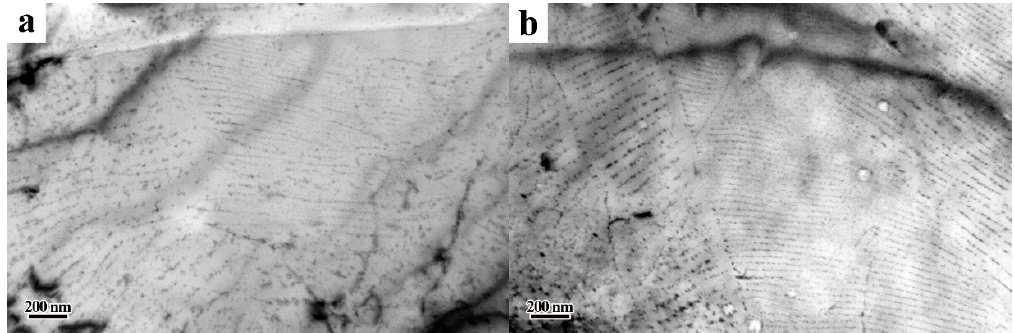
Figure 8. TEM micrographs showing carbides in steel isothermally treated at 600 °C for 3 h. ( a ) Steel LC650+600T and ( b ) Steel LC600+600T.